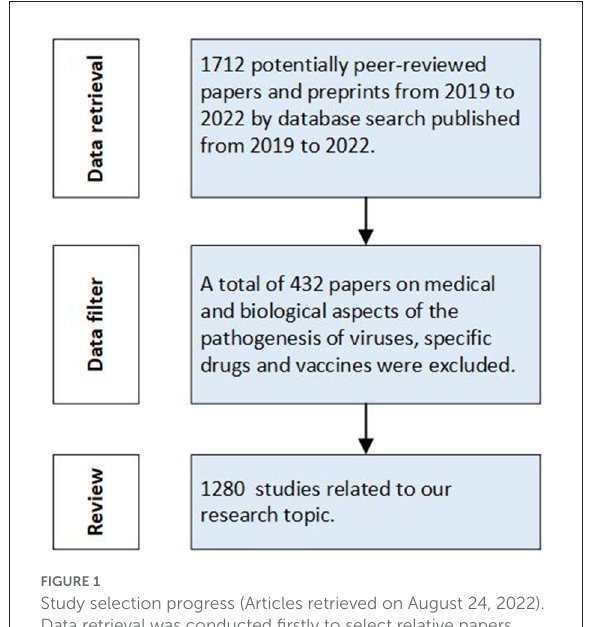
FIGURE1 Study selection progress (Articles retrieved on August 24, 2022). Data retrieval was conducted firstly to select relative papers from 2019–2022. Then we filtered the retrieval data and reviewed the studies related to our research topic.